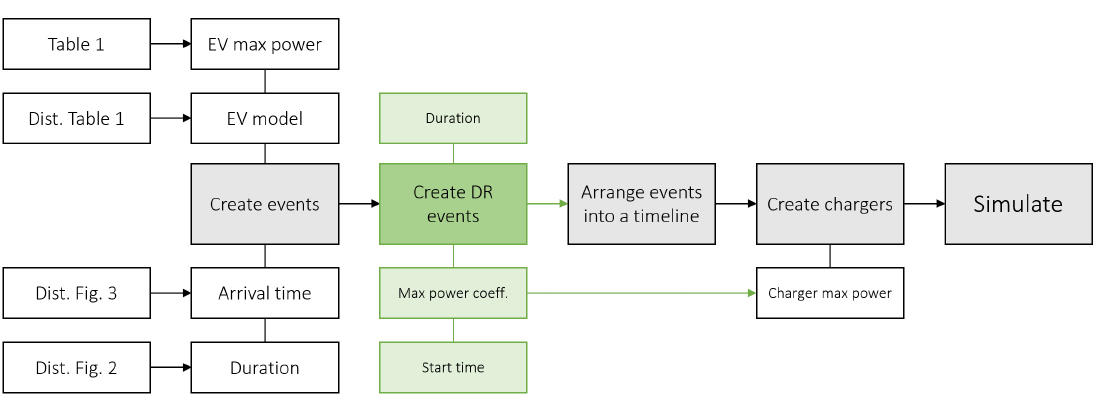
Figure 6. Simulation steps with inclusion of demand response (DR) events. Additions to Figure 4 are highlighted in